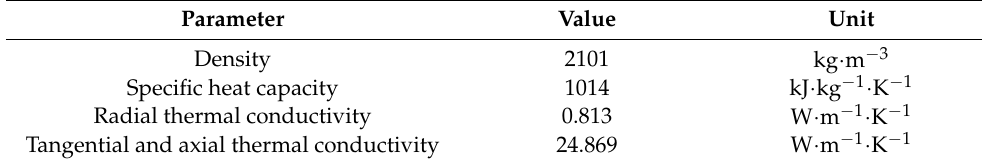
Figure 1. Mesh model of the battery module. Table 1. Battery module